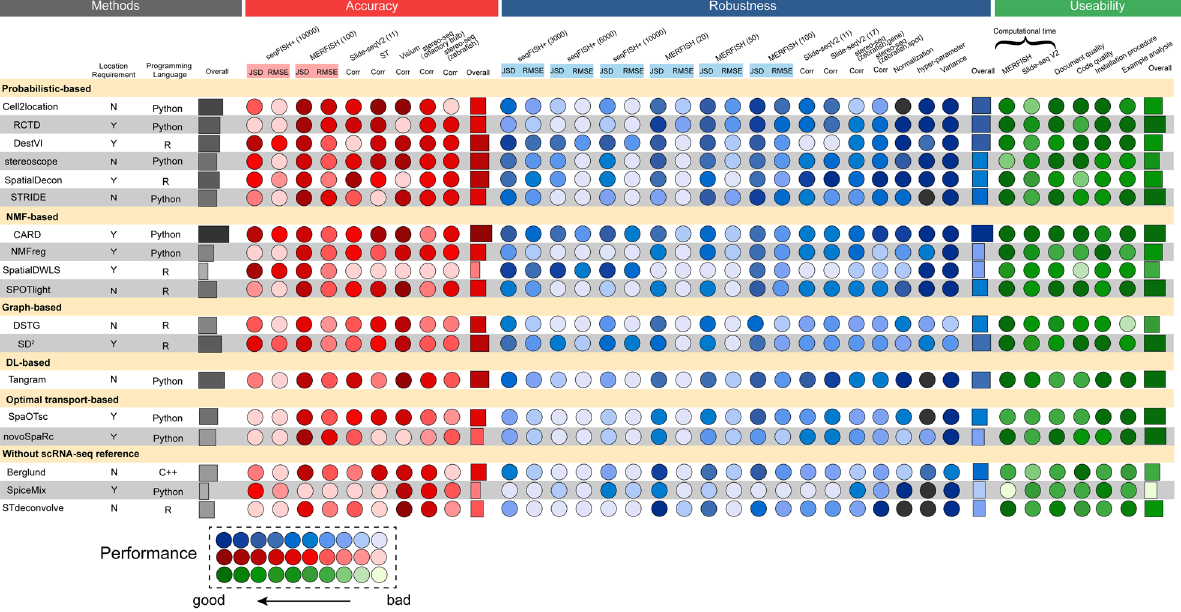
shade represents better performance. The black dots shown in normalization and hyperparameter of robustness meant that the methods required the raw count